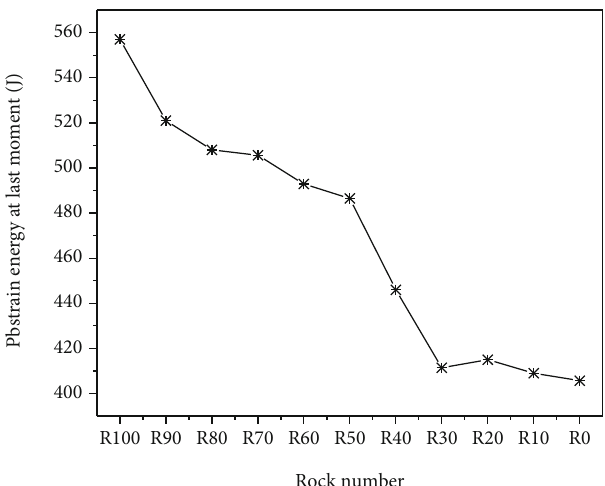
Figure 22: Strain energy contained in the sample at the end of the